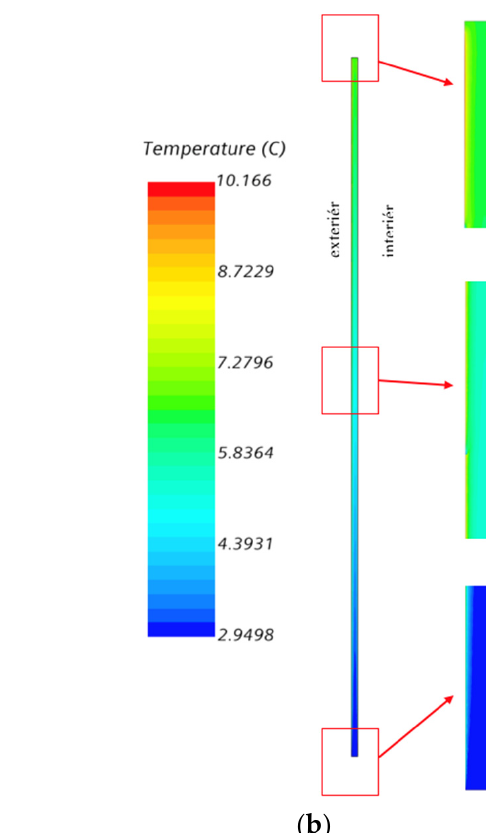
Figure 15. Visualization of façade temperature field—horizontal cross-section at height of 10 m winter extreme.